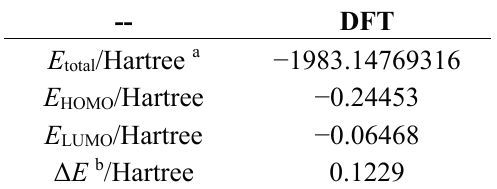
Table 1. Total energy and frontier orbital